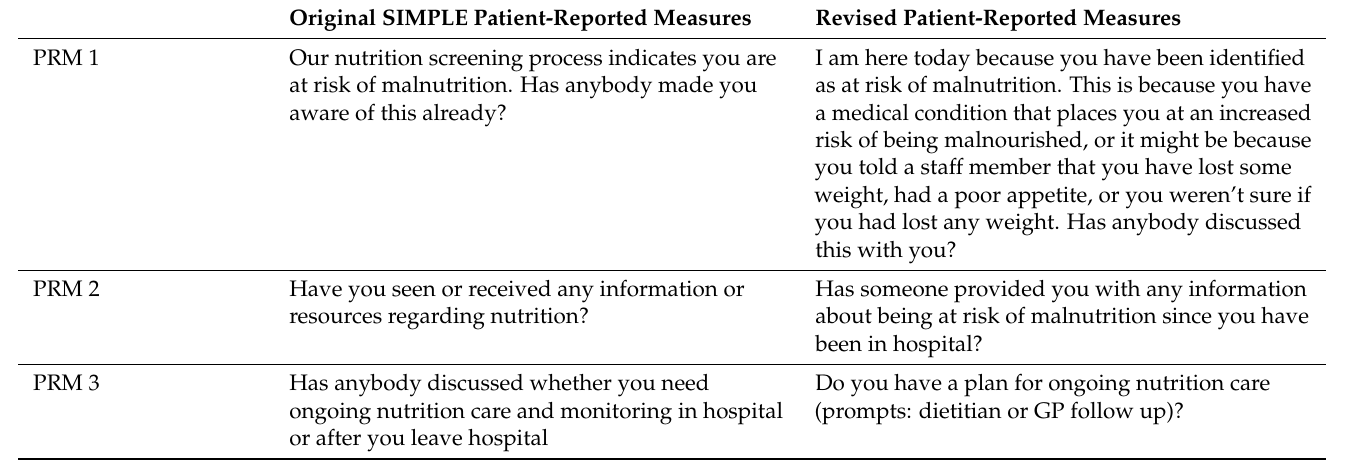
Table 1. Patient-reported measures of key nutrition care processes.